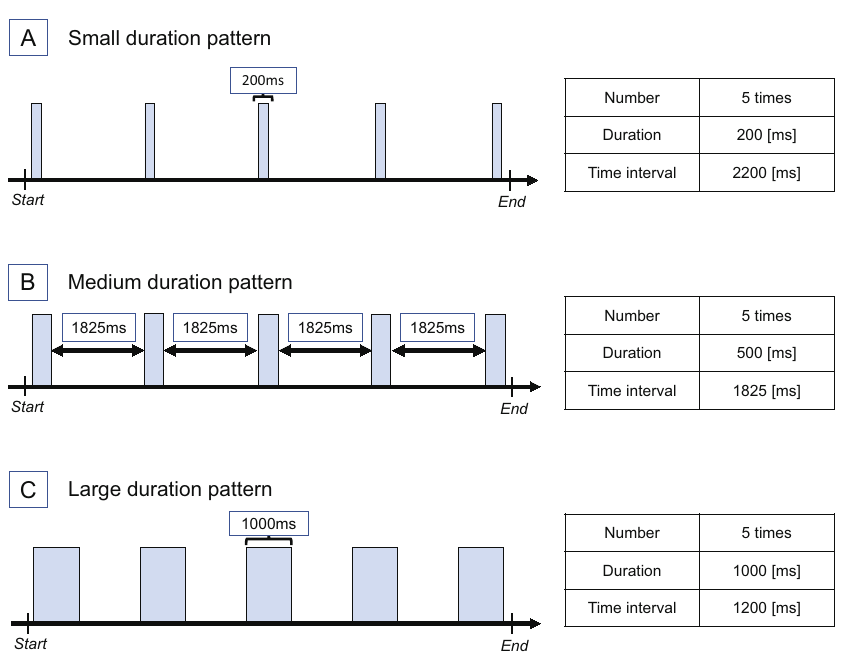
Figure 6. Stimulus pattern of Experiment 2. Three patterns with a different duration of stimuli.